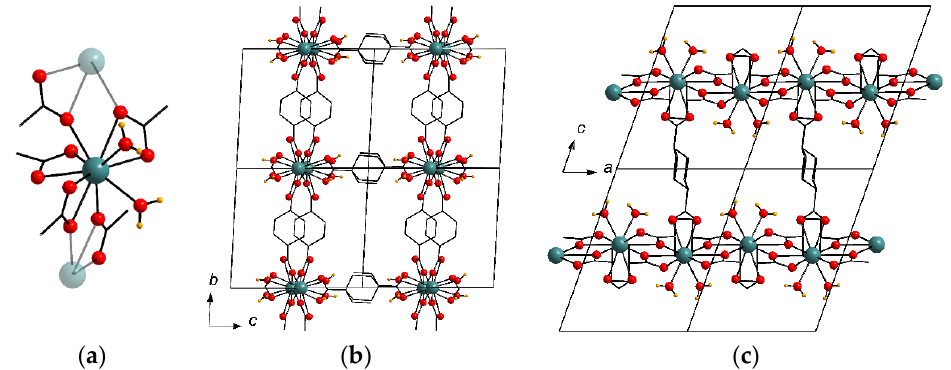
Figure 3. La(III) environment in 1 . The neighboring La(III) ions are shown as transparent. O atoms are red, H atoms are orange ( a ). View along different crystallographic axes in 1 : a ( b ) and b ( c ). Guest molecules and H atoms of chdc ligand are not shown. Only one possible position of disordered ( κ 2 ; κ 2 )-chdc cyclohexane ring is shown.